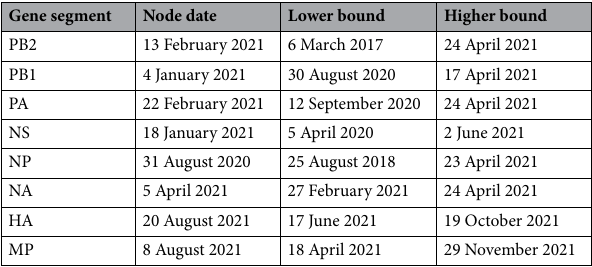
Table 3. Dates for the most recent common ancestor (MRCA) of all gene segments.